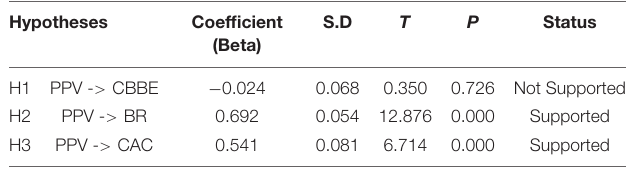
TABLE 5 | Hypotheses testing (Direct